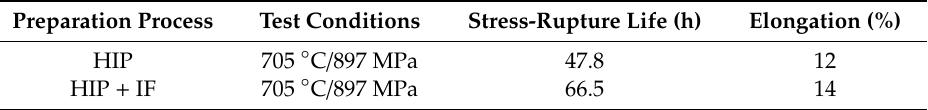
Table 2. The stress-rupture properties of FGH100L alloy under different processes.